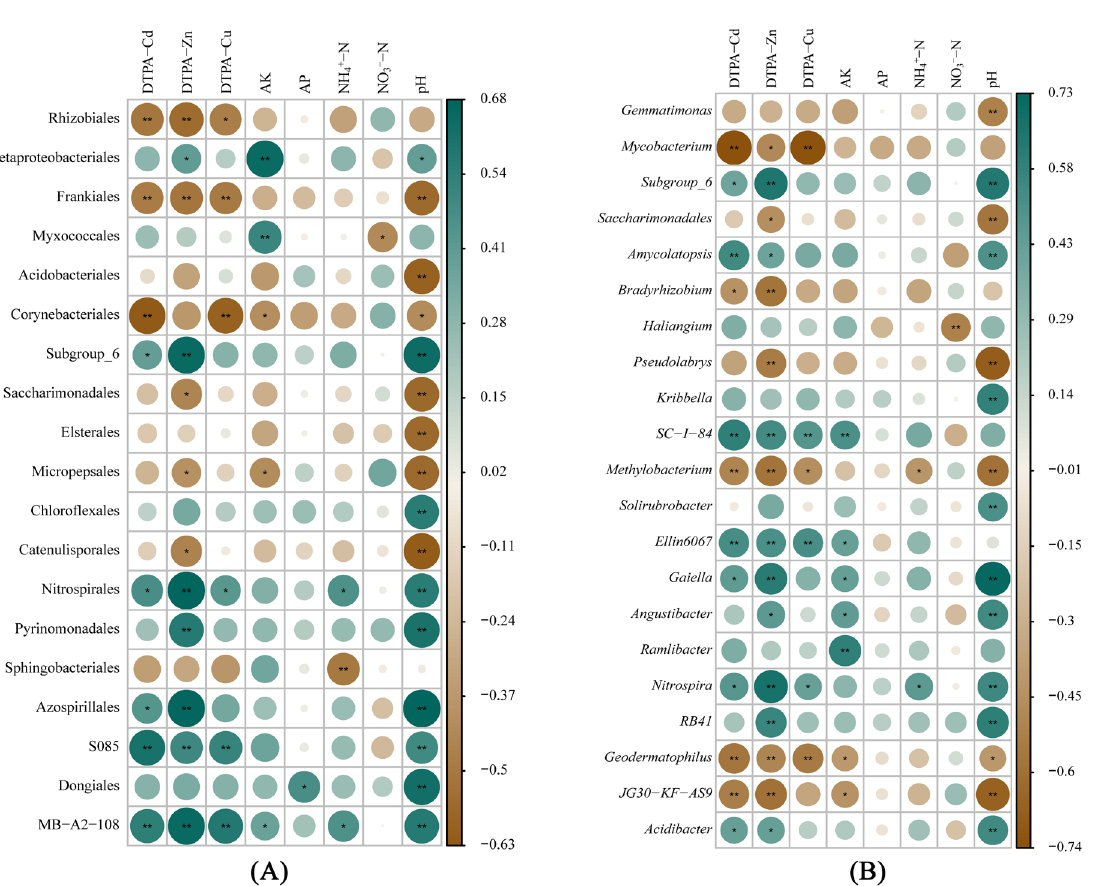
Figure 5. Correlation heatmaps between soil physicochemical properties and bacterial abundance ( A ) order; ( B ) genus. The p value filter is set to 0.05 and the R value filter is set to 0.5. The color and circle size indicate the R value, which is correlation, and the asterisk indicates significance.